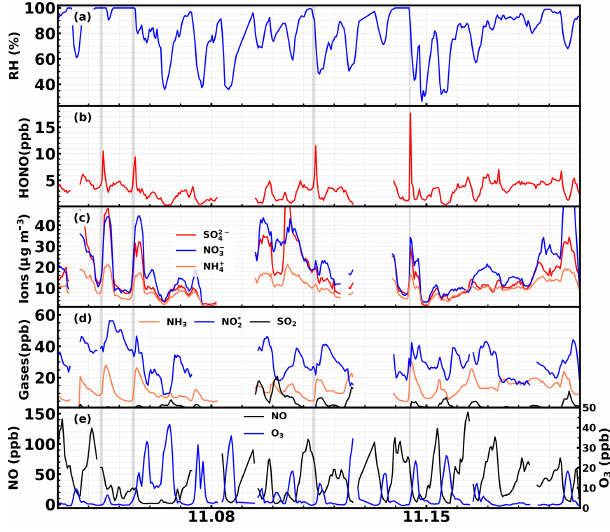
Figure 2. Time series of ambient (a) RH; (b) HONO; (c) sulfate, nitrate and ammonium; (d) NH 3 , NO ∗ O 3 during the observation period.